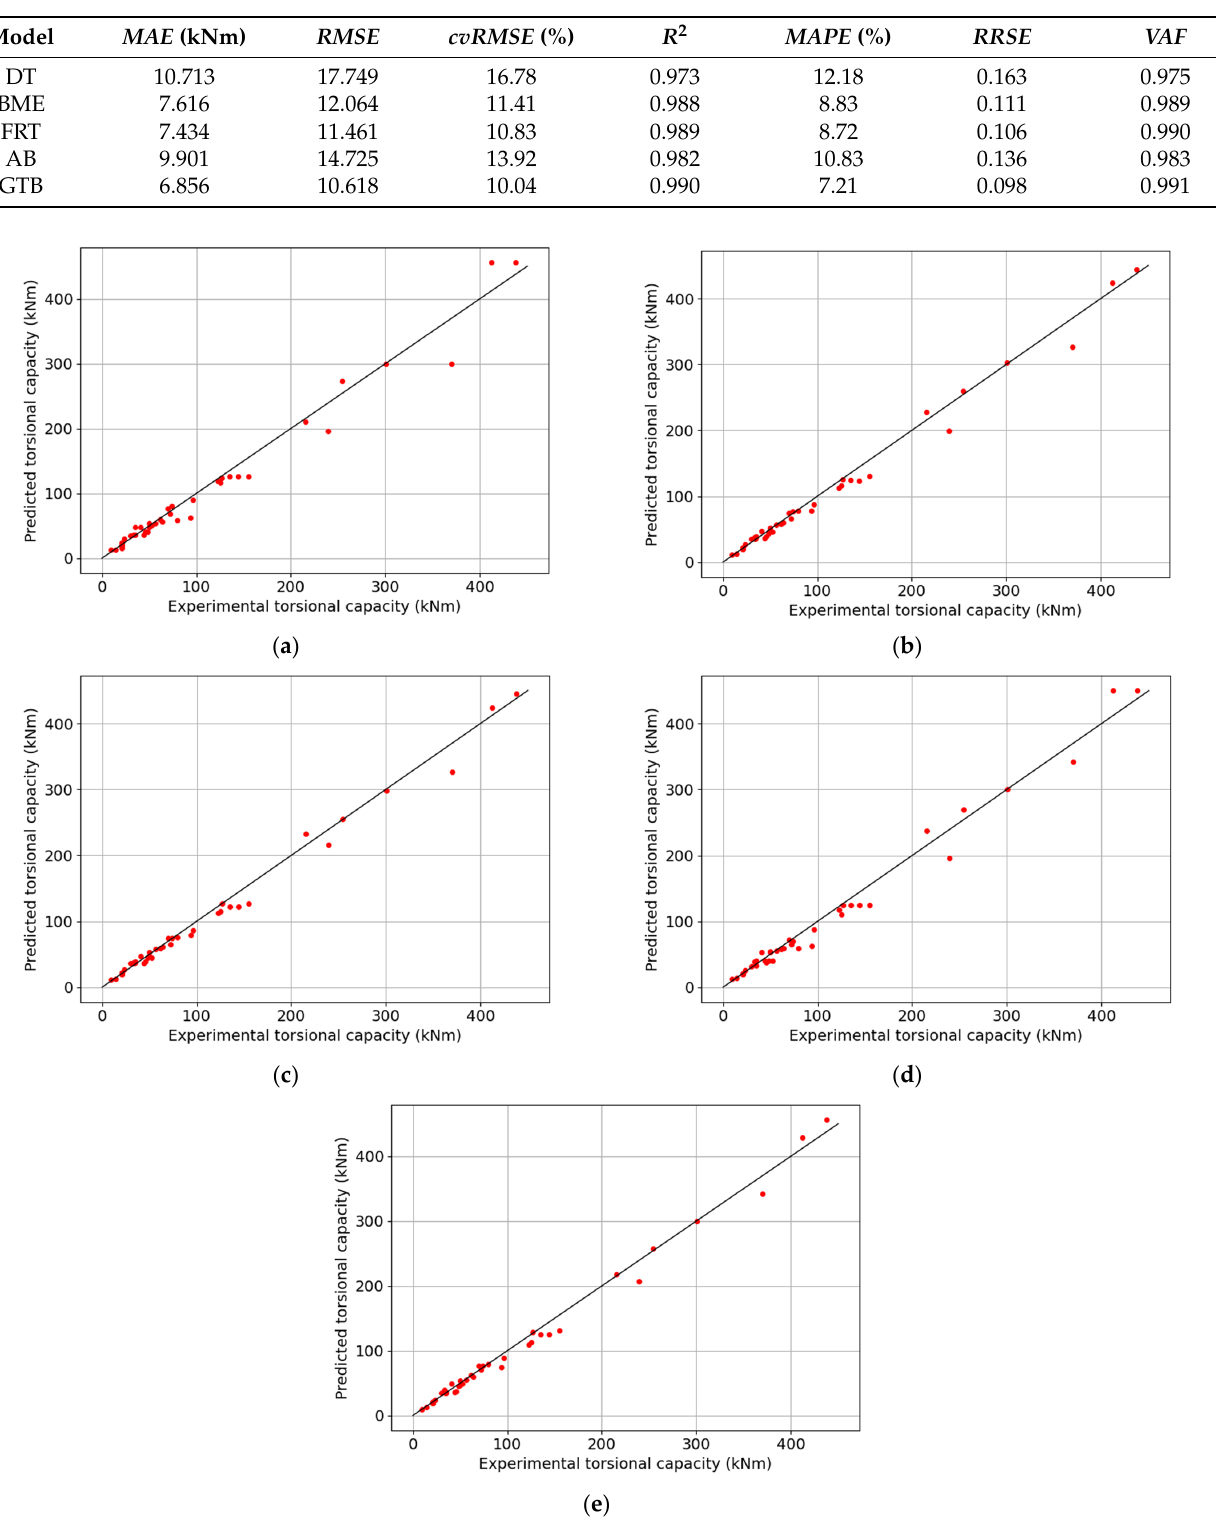
Figure 9. Predictions results: ( a ) DT, ( b ) BME, ( c ) FRT, ( d ) AB and ( e ) GTB. Overall, the difference between the predicted and actual torsional capacity ( MAE ) is low, with an average between 6.9 and 10.7 kNm. The low values obtained for RMSE , cvRMSE , MAPE and RRSE , and the high values obtained for R 2 and VAF are very